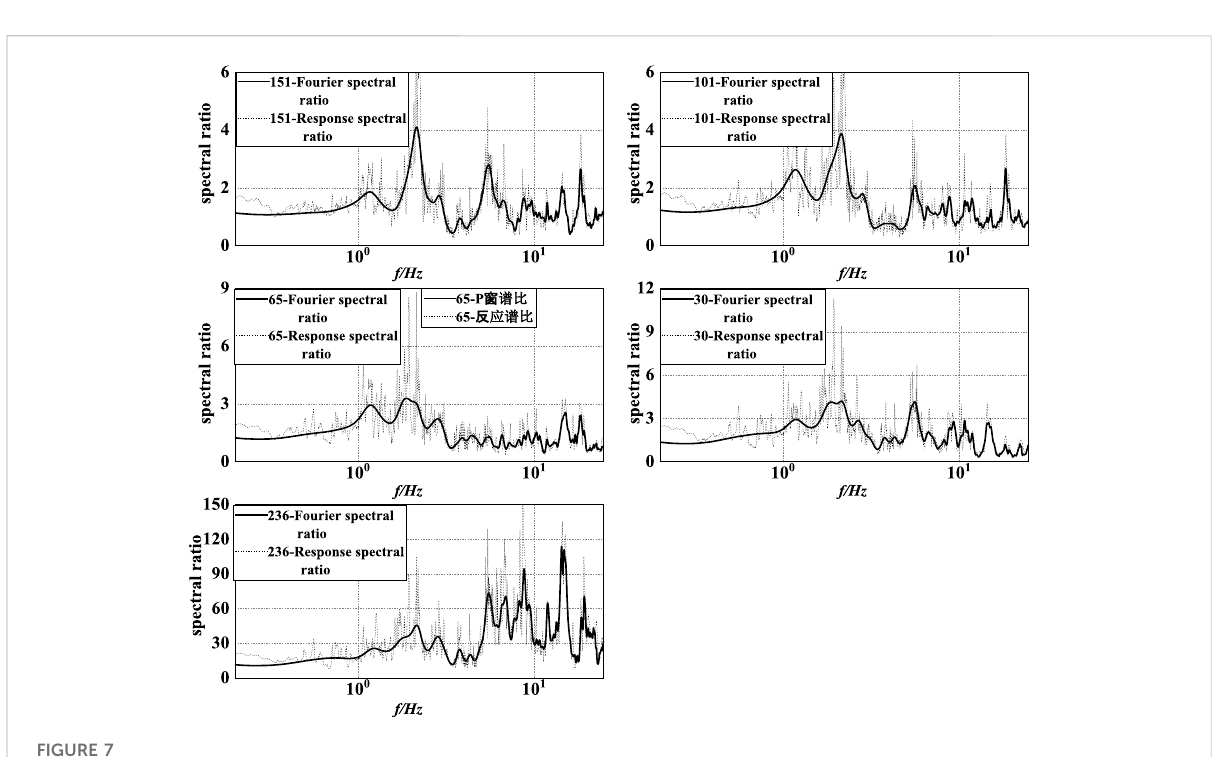
FIGURE 7 Fourier and response spectral ratios in the vertical direction (Guye strong motion